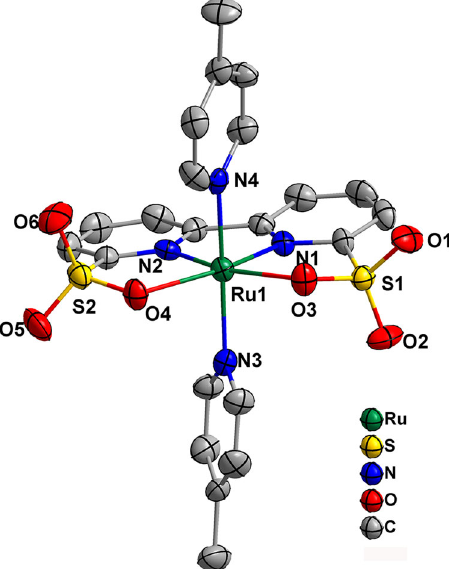
Fig. 3 Electrochemical behavior under acidic conditions. a CVs of 1.0 mM Ru-bda and Ru-bds in pH 1.0 tri fl ic acid aqueous solution containing 20% volume CH 3 CN with scan rate of 100 mV s − 1 (the diameter of glassy carbon working electrode is 3 mm). b CV scan rate dependence with 1.0 mM Ru-bds from 0.91 to 1.41 V and scan rate varies from 50 to 800 mV s − 1 . c Dependence of the peak current for the Ru III/II couple ( E 1/2 = 1.18 V) on the square root of scan